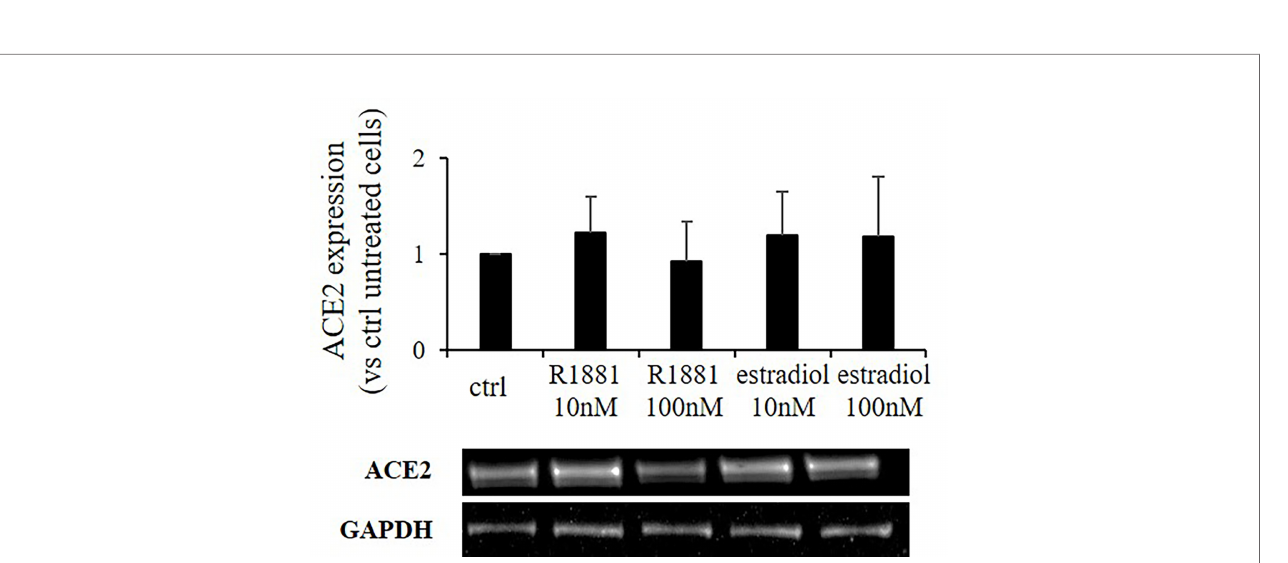
FIGURE 3 | R1881 and estradiol do not in fl uence ACE2 protein expression. Representative Western blot image and densitometrical analysis showing ACE2 protein expression in Calu-3 cells stimulated or not with the indicated concentration of R1881 and estradiol for 30 h in FBS-CSS medium. GAPDH was considered as housekeeping gene and was used for normalization. Experiments were replicated three times and results are expressed as mean ± SD.